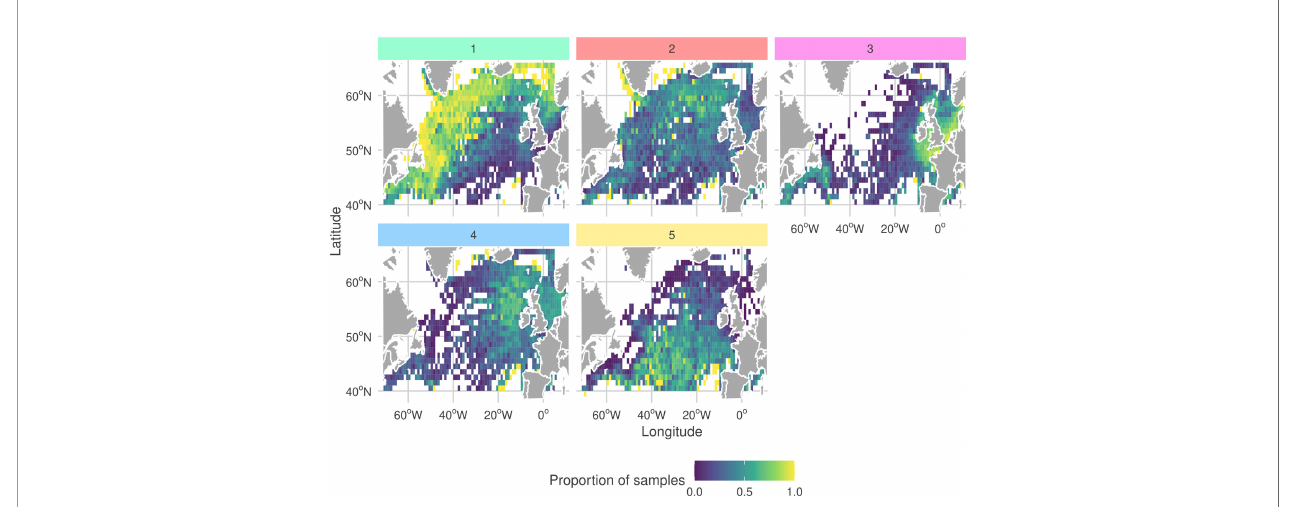
FIGURE 8 | Proportion of samples at each CPR sampling site in which each sub-community was determined to be present (samples containing least 30% (rounded down) of a sub-community ’ s members). More yellow corresponds to a higher proportion of samples. To highlight spatial extent, only sites which included at least one observation of each sub-community are shown. Facet colors and numeric-labels follow Figure 2